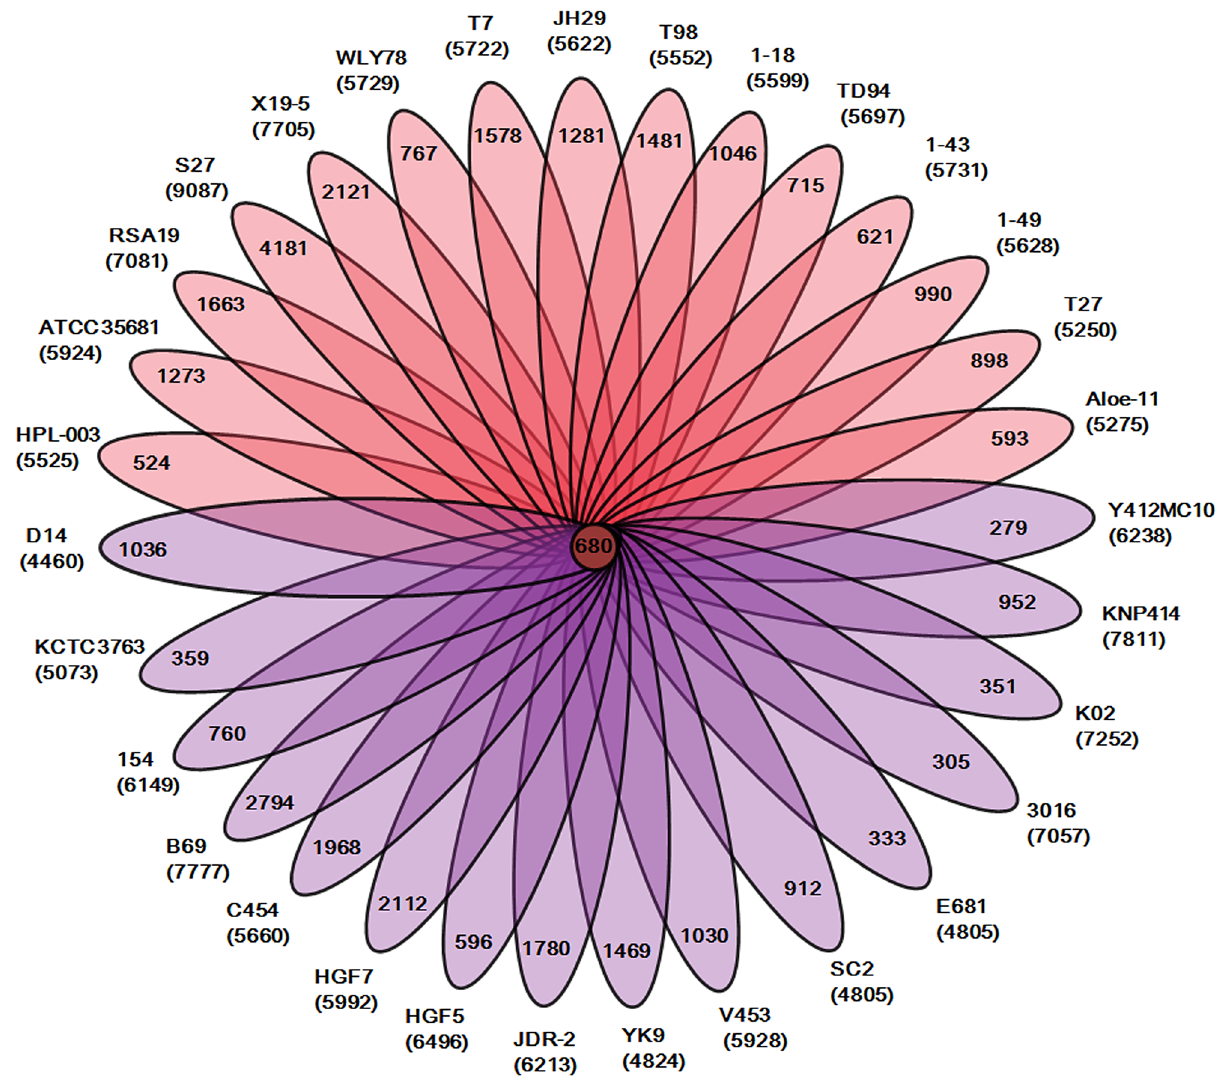
Figure 1. Genomic diversity of strains in the genus Paenibacillus . Each strain is represented by an oval that is colored: N 2 -fixing strains (red), non- N 2 -fixing strains (purple). The number of orthologous coding sequences (CDSs) shared by all strains (i.e., the core genome) is in the center. Overlapping regions show the number of CDSs conserved only within the specified genomes. Numbers in non-overlapping portions of each oval show the number of CDSs unique to each strain. The total number of protein coding genes within each genome is listed below the strain name.